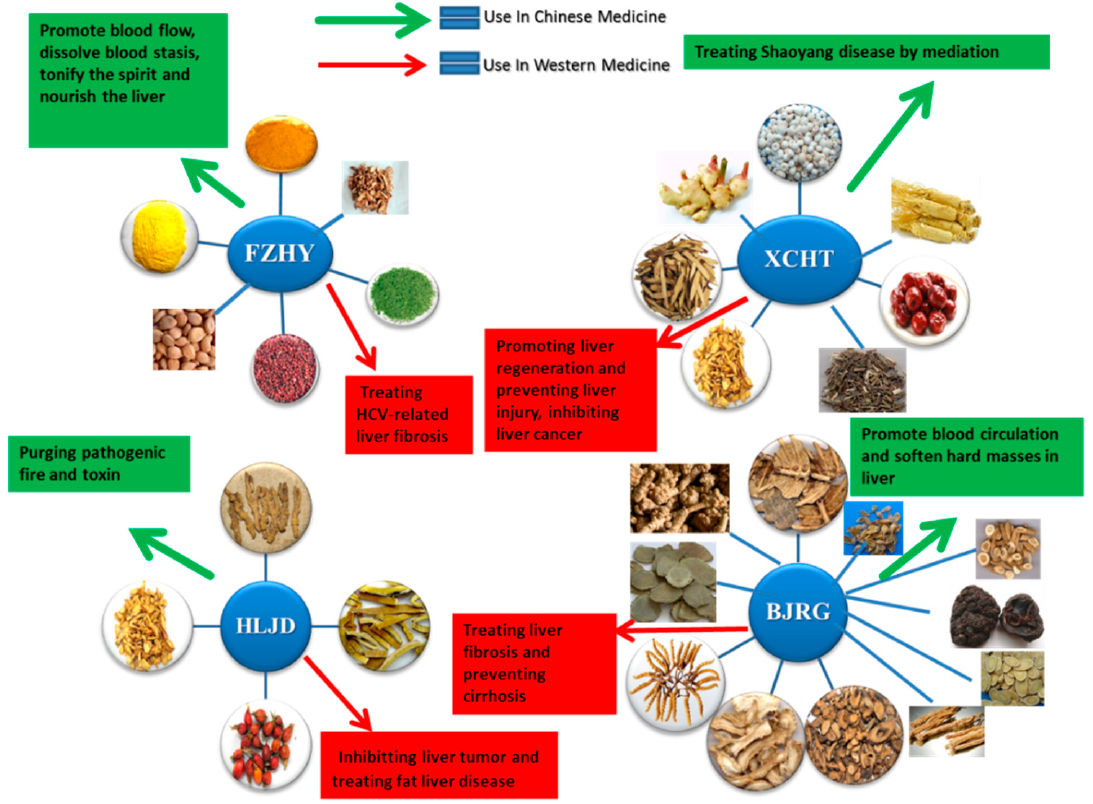
Figure 1. The traditional Chinese medicine (TCM) herbal formulas for chronic liver disease treatment. FZHY = Fuzheng Huayu tablet; XCHT = Xiao Chai Hu Tang; HLJD = Huanglian Jiedu decoction; BJRG = Biejia ruangan tablet.